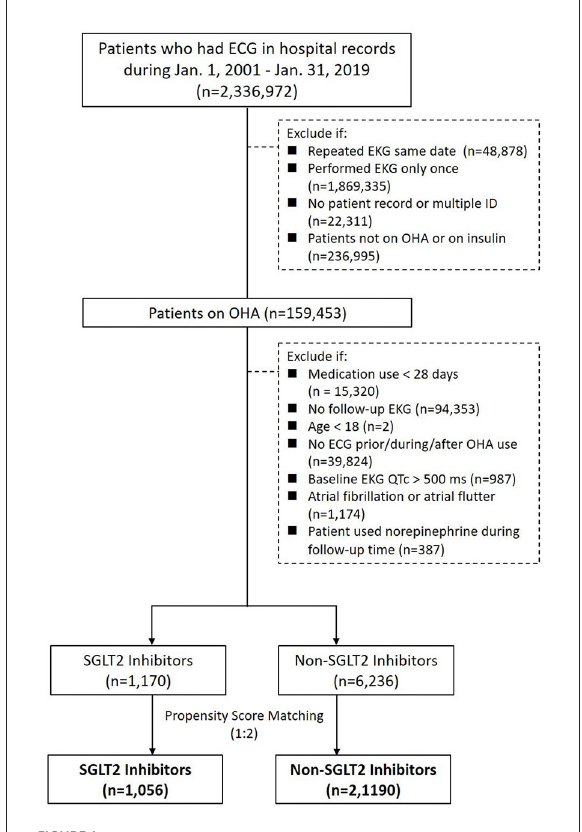
FIGURE1 Study design and screening criteria flow chart for the inclusion of patients with T2DM using SGLT2 inhibitors and non-SGLT2 inhibitors with EKG.